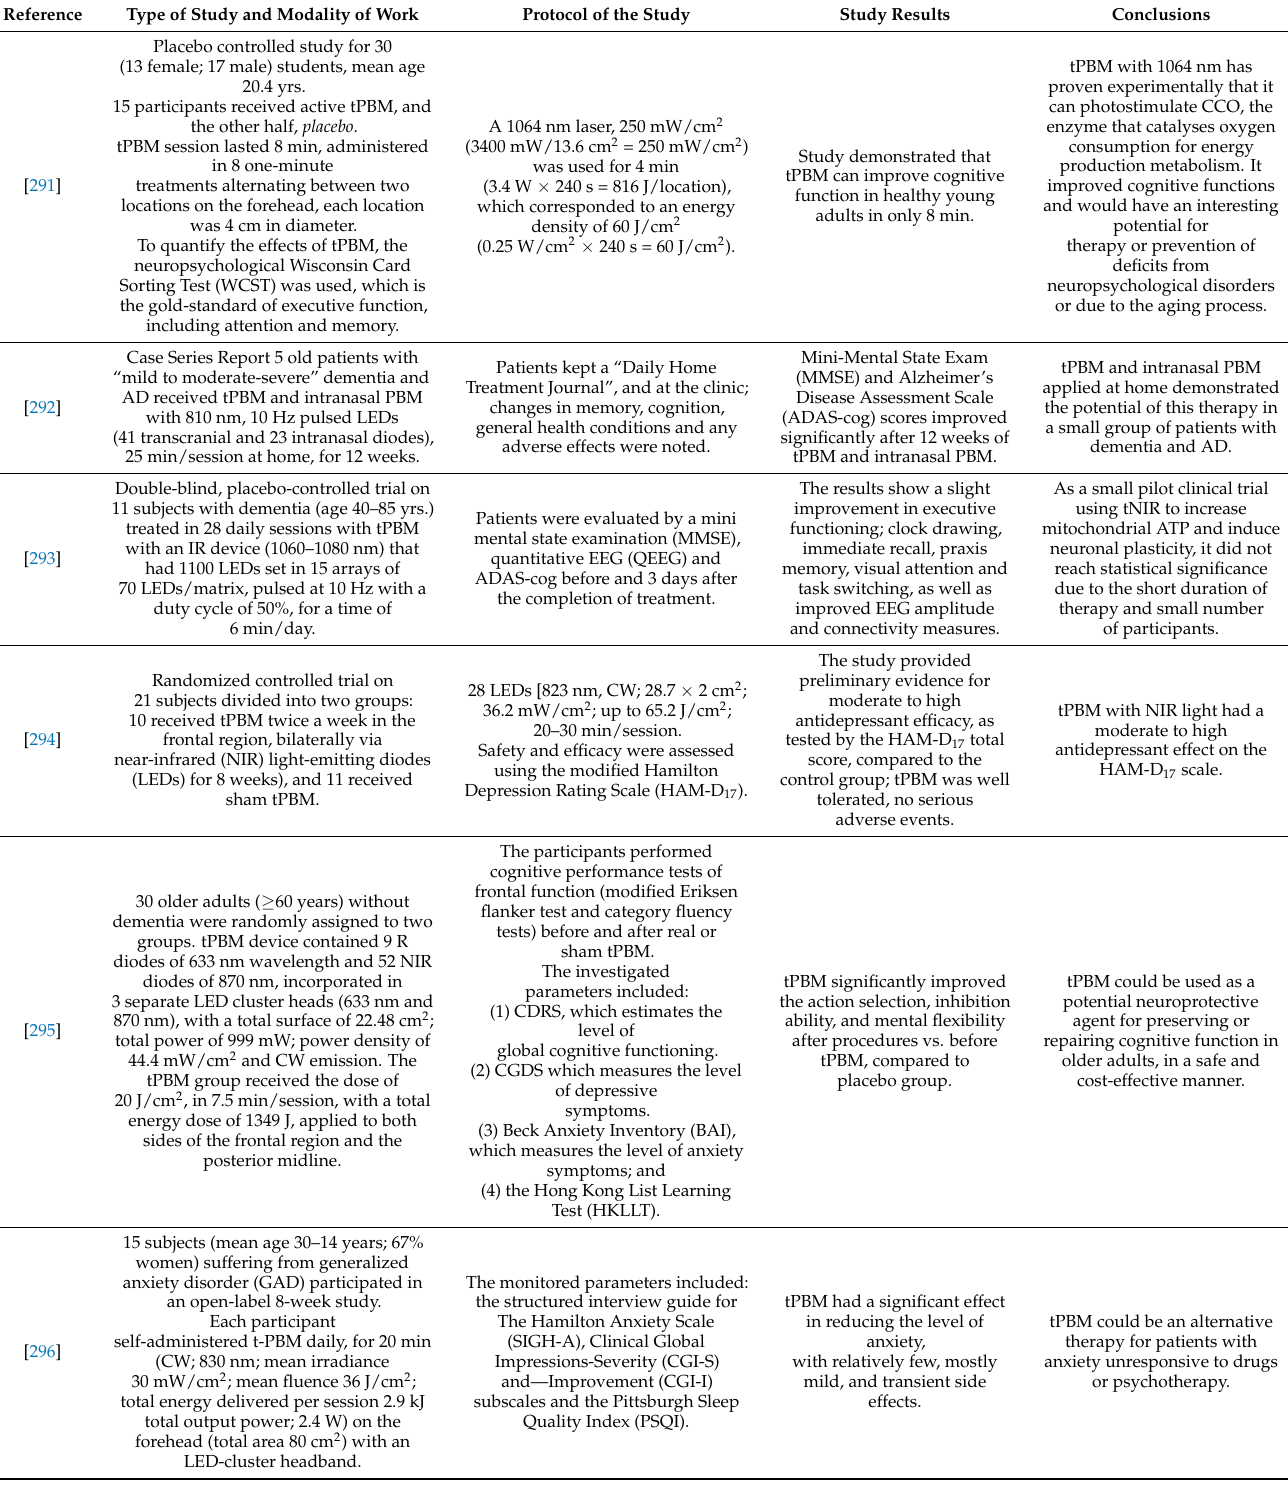
Table 3. Brain photobiomodulation studies in human